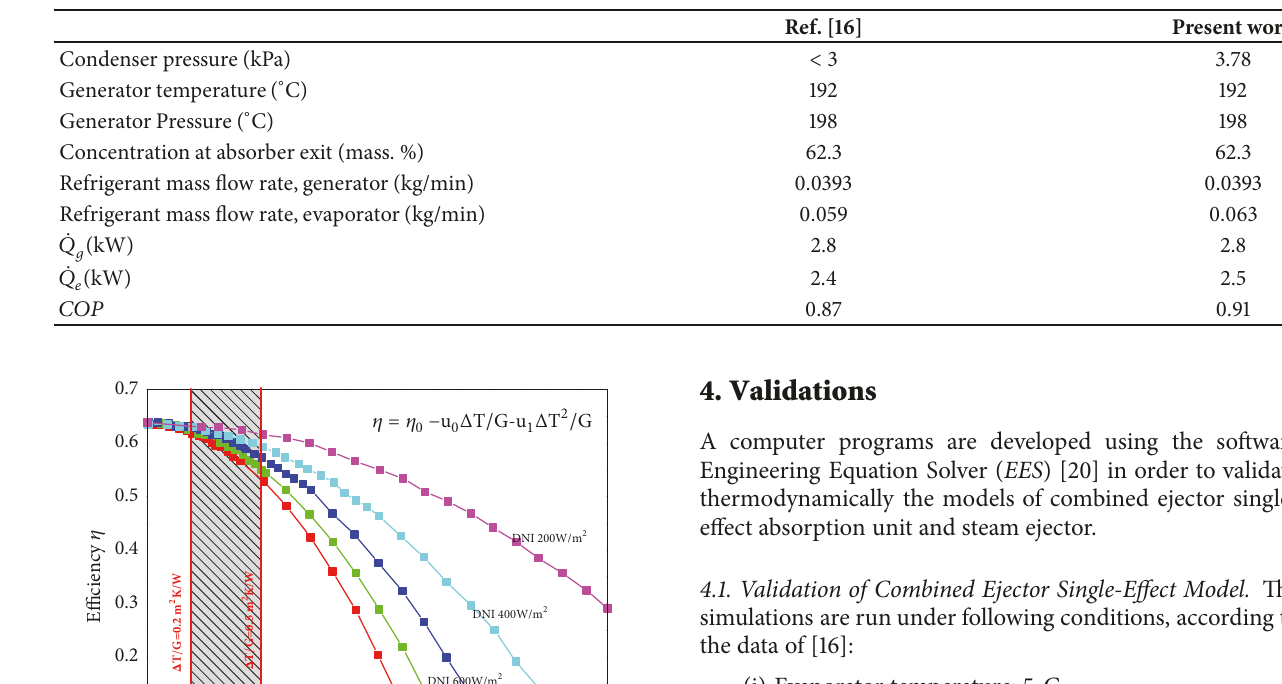
Table 4: Comparison of results from [16] with those of present work.